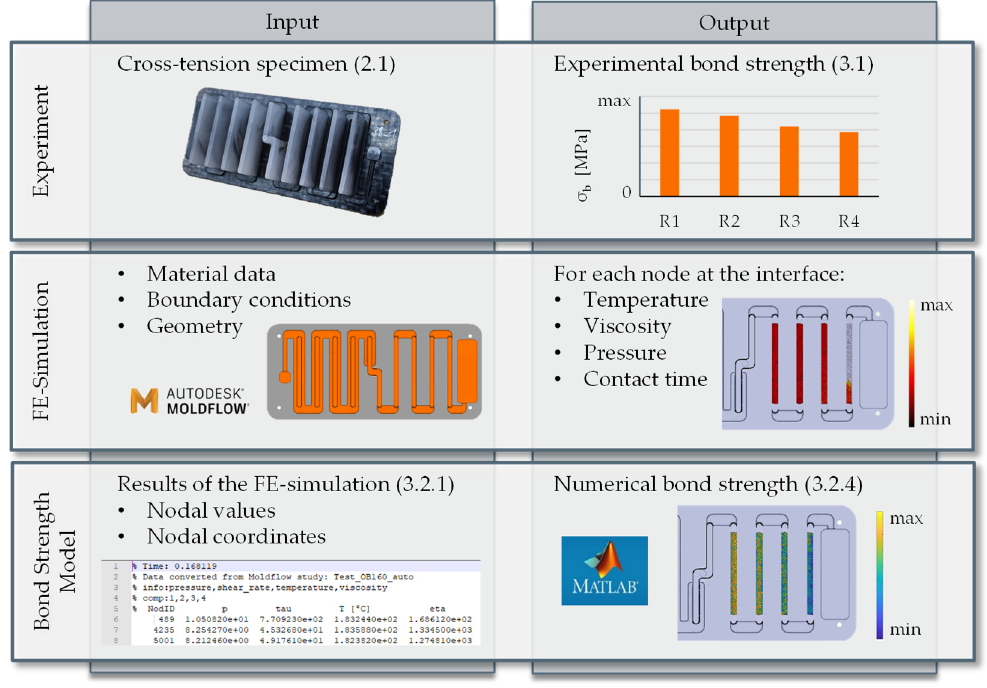
Figure 4. Overview of the workflow for determining the bond strength in OTC.